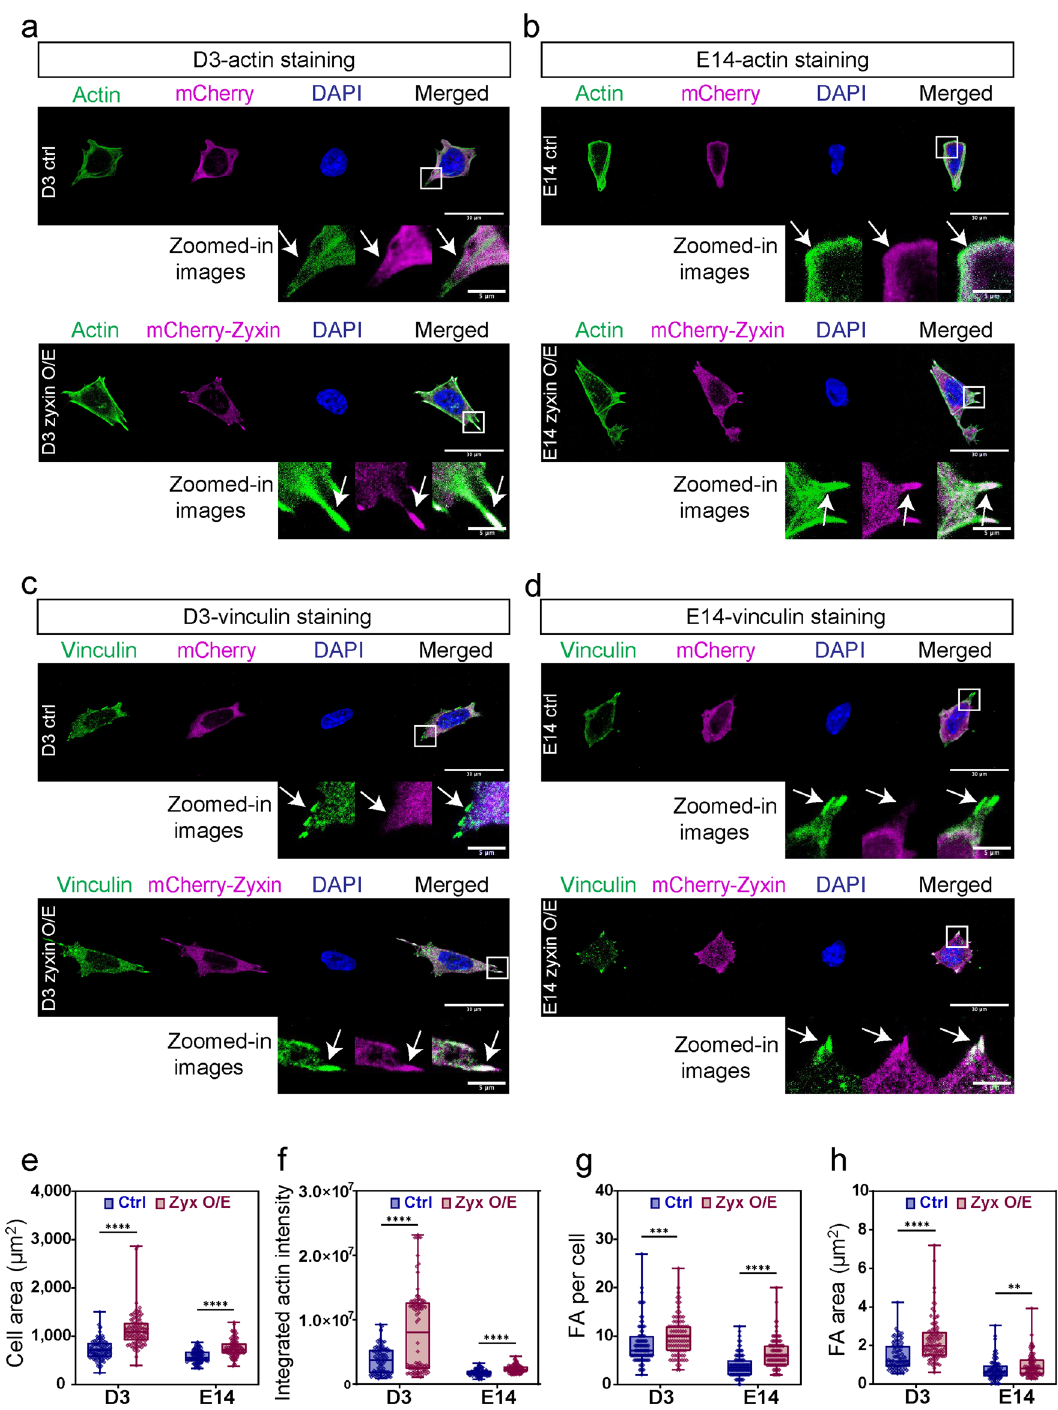
Fig. 5 Zyxin overexpression increases abundance of f-actin and focal adhesions. a – d To compare stress fi bers and focal adhesions, D3/E14 transfected with mCherry vector control (ctrl) and mCherry-Zyxin (zyxin O/E) were immuno-stained with Phalloidin-Alexa 488 ( a , b ) and vinculin ( c , d ). White box areas were further ampli fi ed and shown as the zoomed in images. White arrows denoted f-actin and focal adhesion. Z-stacked images with maximum intensity projection were shown. Representative images from three biological repeats were shown. Scale bar: 30 μ m for original images, 5 μ m for zoomed in images. e projected cell area, f integrated actin intensity, g number of focal adhesions per cell, h projected focal adhesion areas were statistically analyzed and plotted. Quanti fi ed data were from three independent experiments ( N = 90). Mann – Whitney U -test was used to test the differences between the control and zyxin overexpression groups. In the box and whisker plots, the center line is the median, the box-bounds are the 25th and 75th percentiles, and the whiskers are the 0.05 and 0.95 percentiles. ** P ≤ 0.01; *** P ≤ 0.001; **** P ≤